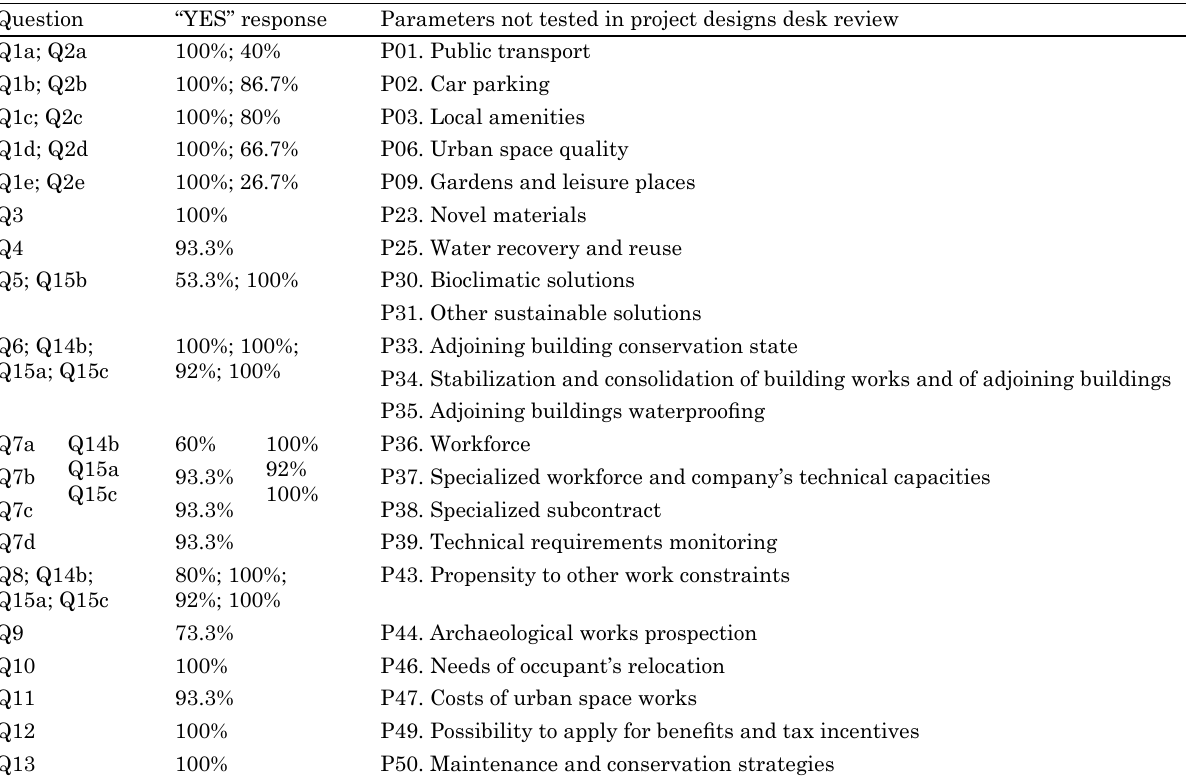
Table 4. Numbering of the interview questions, results and convergence parameters Question “YES” response Parameters not tested in project designs desk